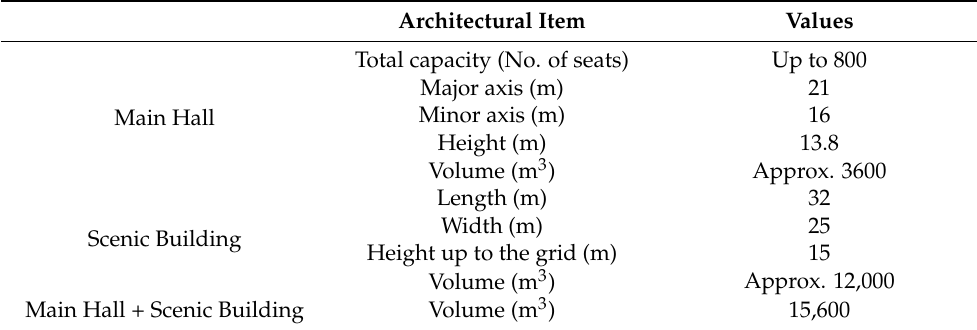
Table 1. Architectural features of the Ponchielli theater of